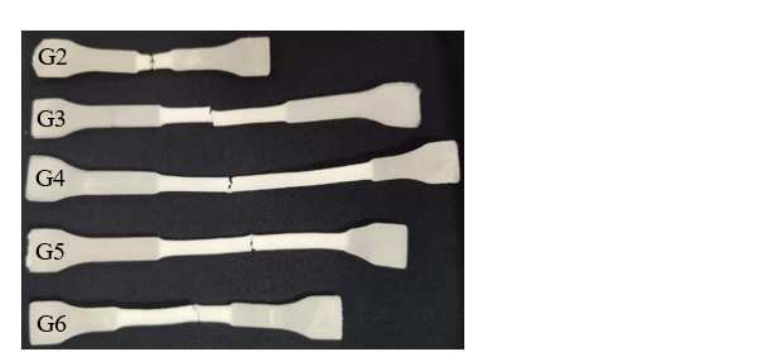
Figure 12. Tensile splines of the PLA/PPC/PLA-g-GMA blends (G2: PLA/PPC; G3: PLA/PPC/PLA- g-GMA; G4: PLA/PPC/PLA-g-GMA/St; G5: PLA/PPC/PLA-g-GMA/AMS; G6: PLA/PPC/PLA-g- GMA/EP).